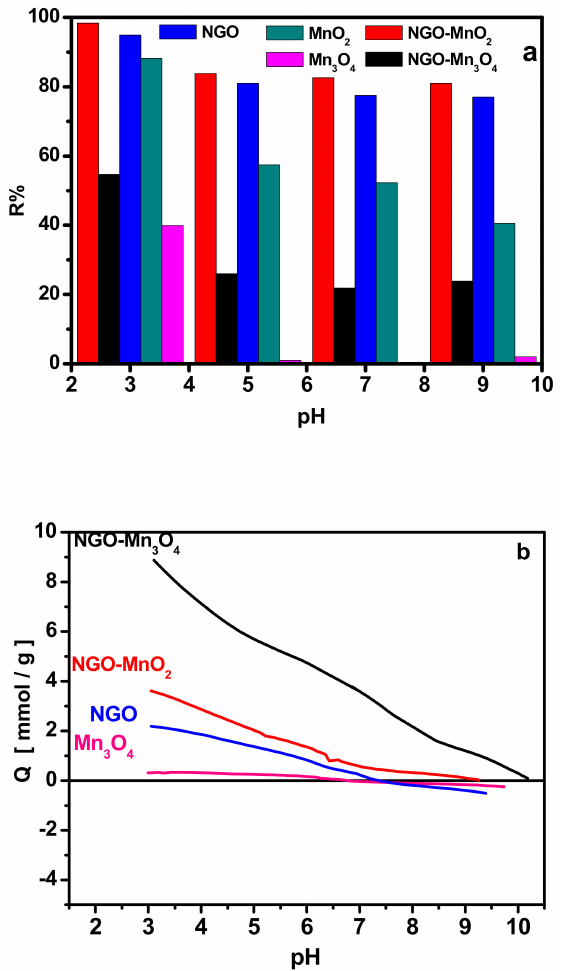
Figure3. ( a )E ff ectofinitialpHonRB5adsorption / degradationontoNGO,MnO 2 , Mn 3 O 4 , NGO–Mn 3 O 4 and NGO–MnO 2 nanocomposites (Co = 100 mg / L, m = 0.01 g, V = 0.02 L); ( b ) potentiometric